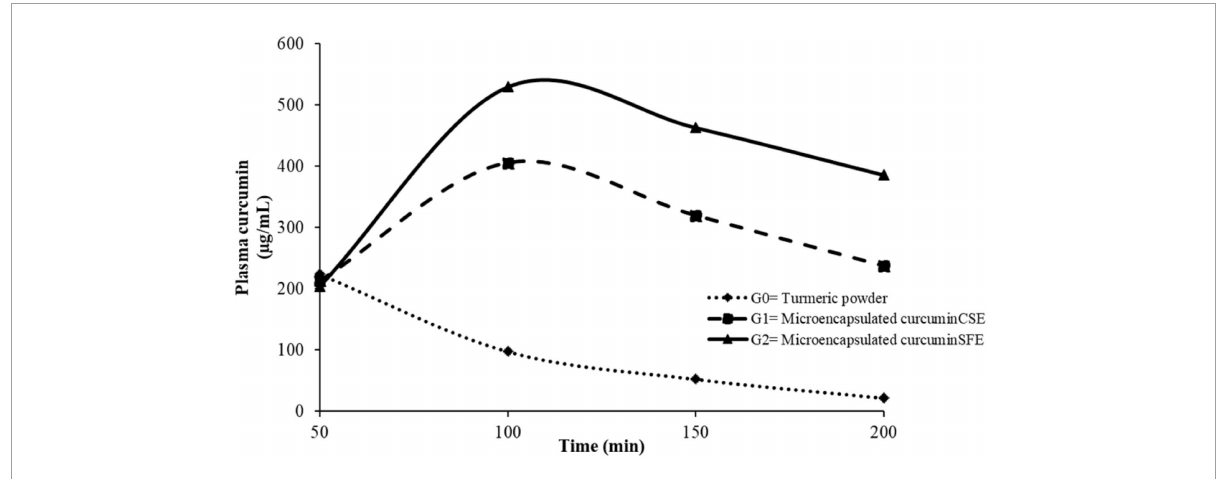
FIGURE1 Curcumin concentration ( µ g/mL) in rat plasma at different time intervals.